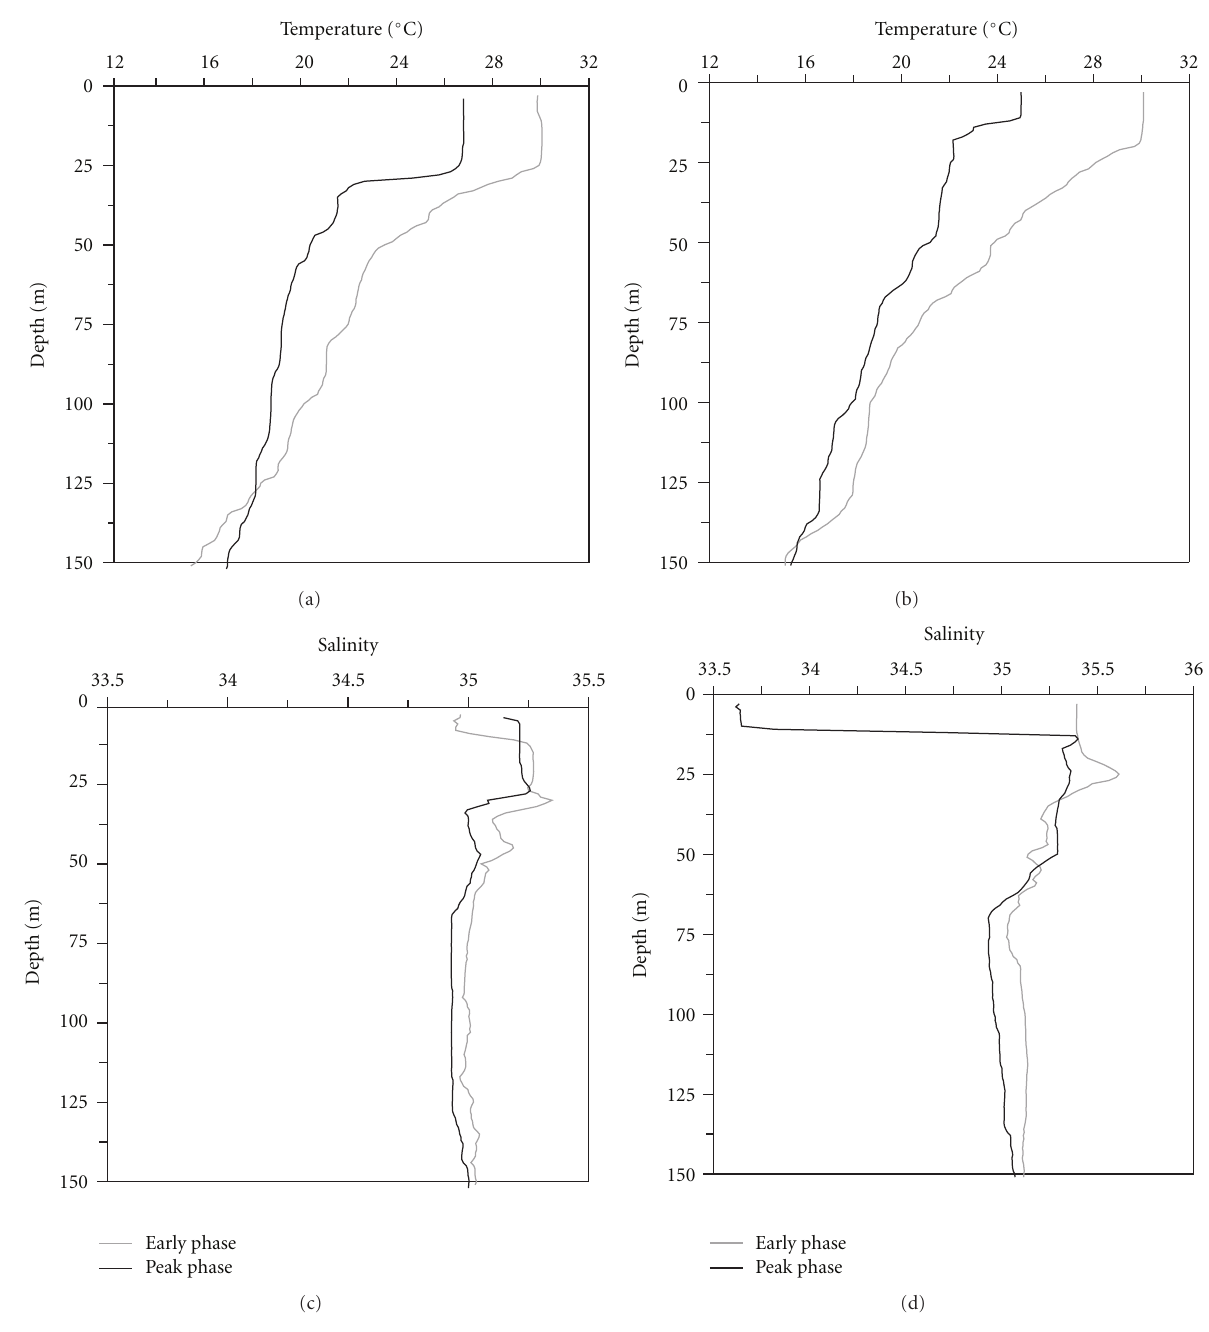
Figure 3: Vertical distribution of temperature ( ◦ C), (a, b) and salinity (c, d) at station 1 and 6, respectively, during early and peak phase.